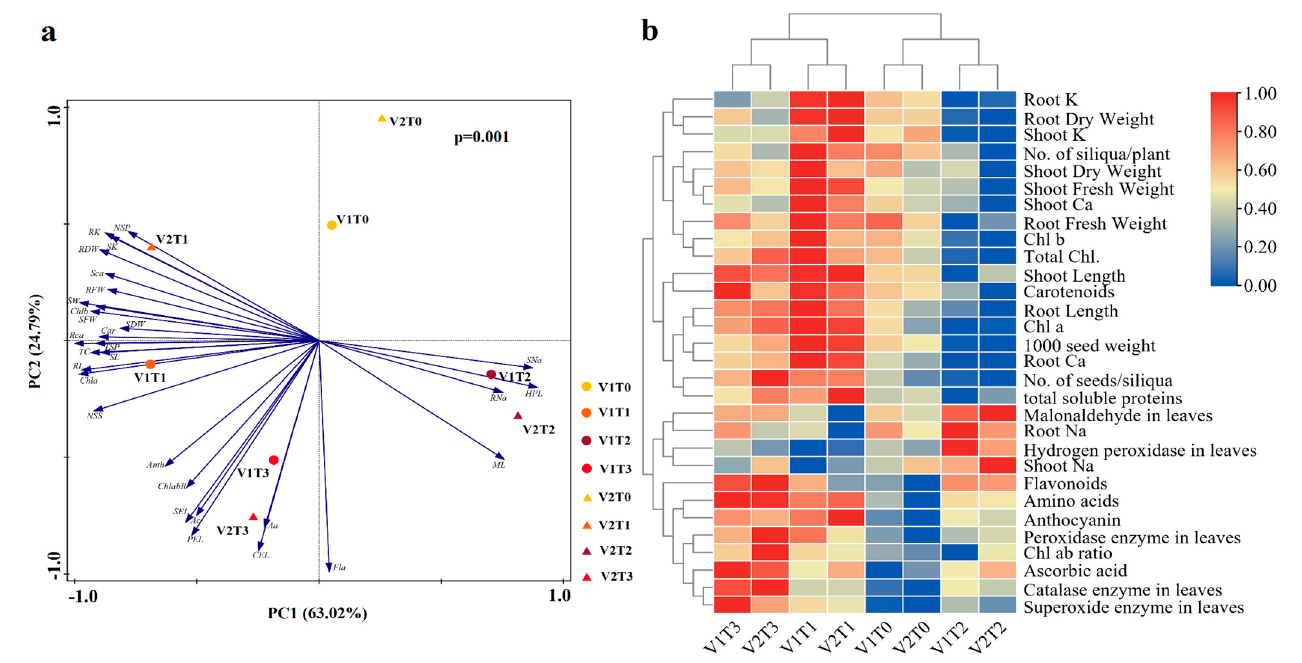
Figure 7. ( a ) Principal components analysis (PCA) and ( b ) heatmap analysis biplot between various attributes of brown mustard revealed the impact of foliar application of ethylenediamine tetraacetic acid (EDTA) under lead (Pb) stress on physiological and biochemical aspects. V1 = Faisal cultivar; V2 = Rohi cultivar; T 0 = 0 mM EDTA+ 0 mM Lead acetate; T 1 = 2.5 mM EDTA + 0 mM Lead acetate; T 2 = 0 mM EDTA + 0.5 mM Lead acetate; T 3 = 2.5 mM EDTA + 0.5 mM Lead acetate. RFW, Root Fresh